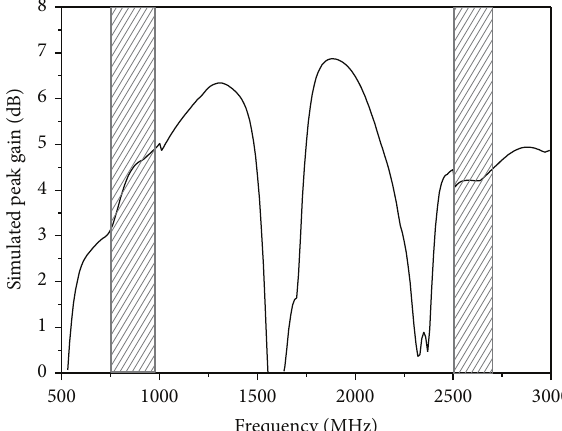
Figure 6: Measured S -parameters of the fabricated MIMO antenna.